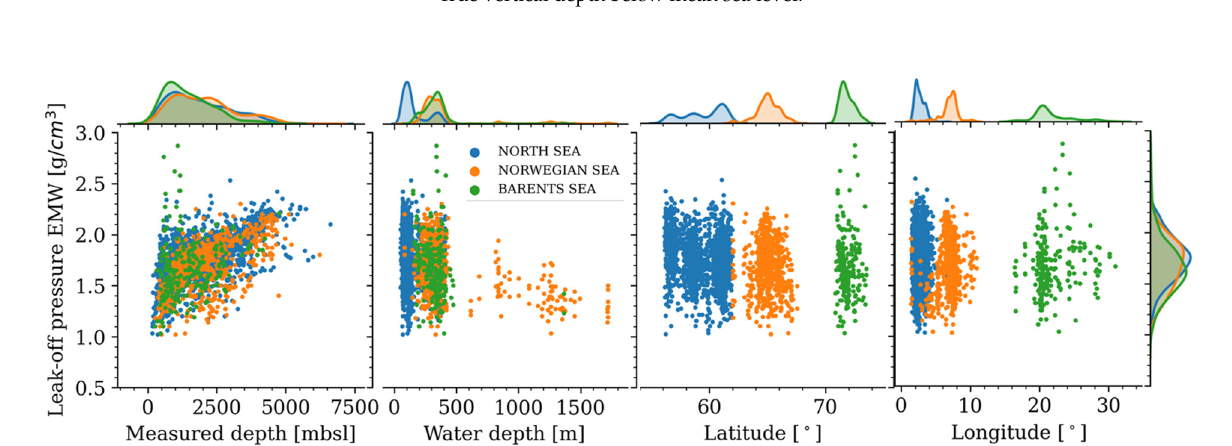
Figure 3. Joint scatter plots of leak-off pressure and geospatial information. 3. Machine Learning Algorithms In this study, three machine learning models to predict the LOP were compared: deep neural network (DNN), random forest (RF), and support vector machine (SVM). The anal- yses were carried out in the Python programming environment with the machine learning